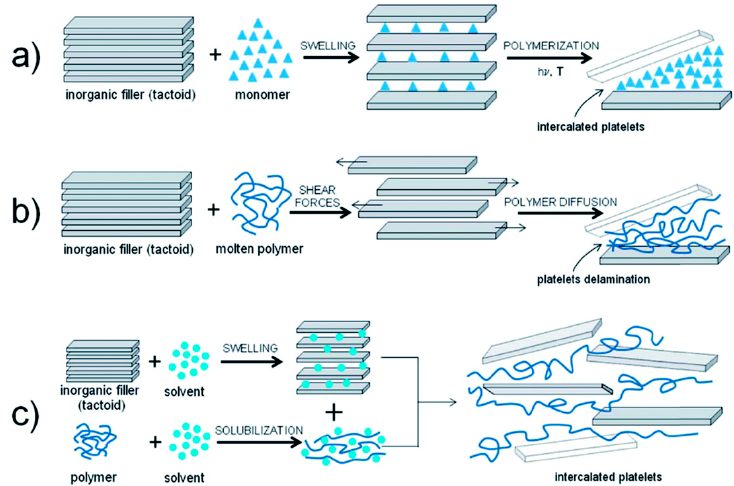
Figure 10. Illustration of ( a ) in situ polymerization, ( b ) melt intercalation and ( c ) solution intercalation. Reproduced with permission from Reference [97]. Open Access 2014, Royal Society of Chemistry.